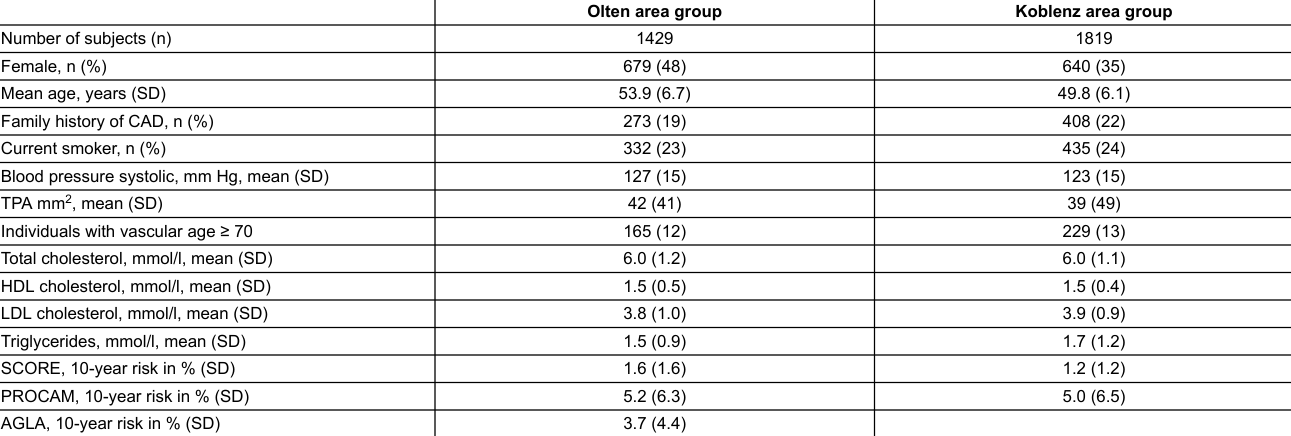
Table 1: Clinical characteristics of the Arteris Group subjects (age 40–65, primary care, no statin or antihypertensive drug use).